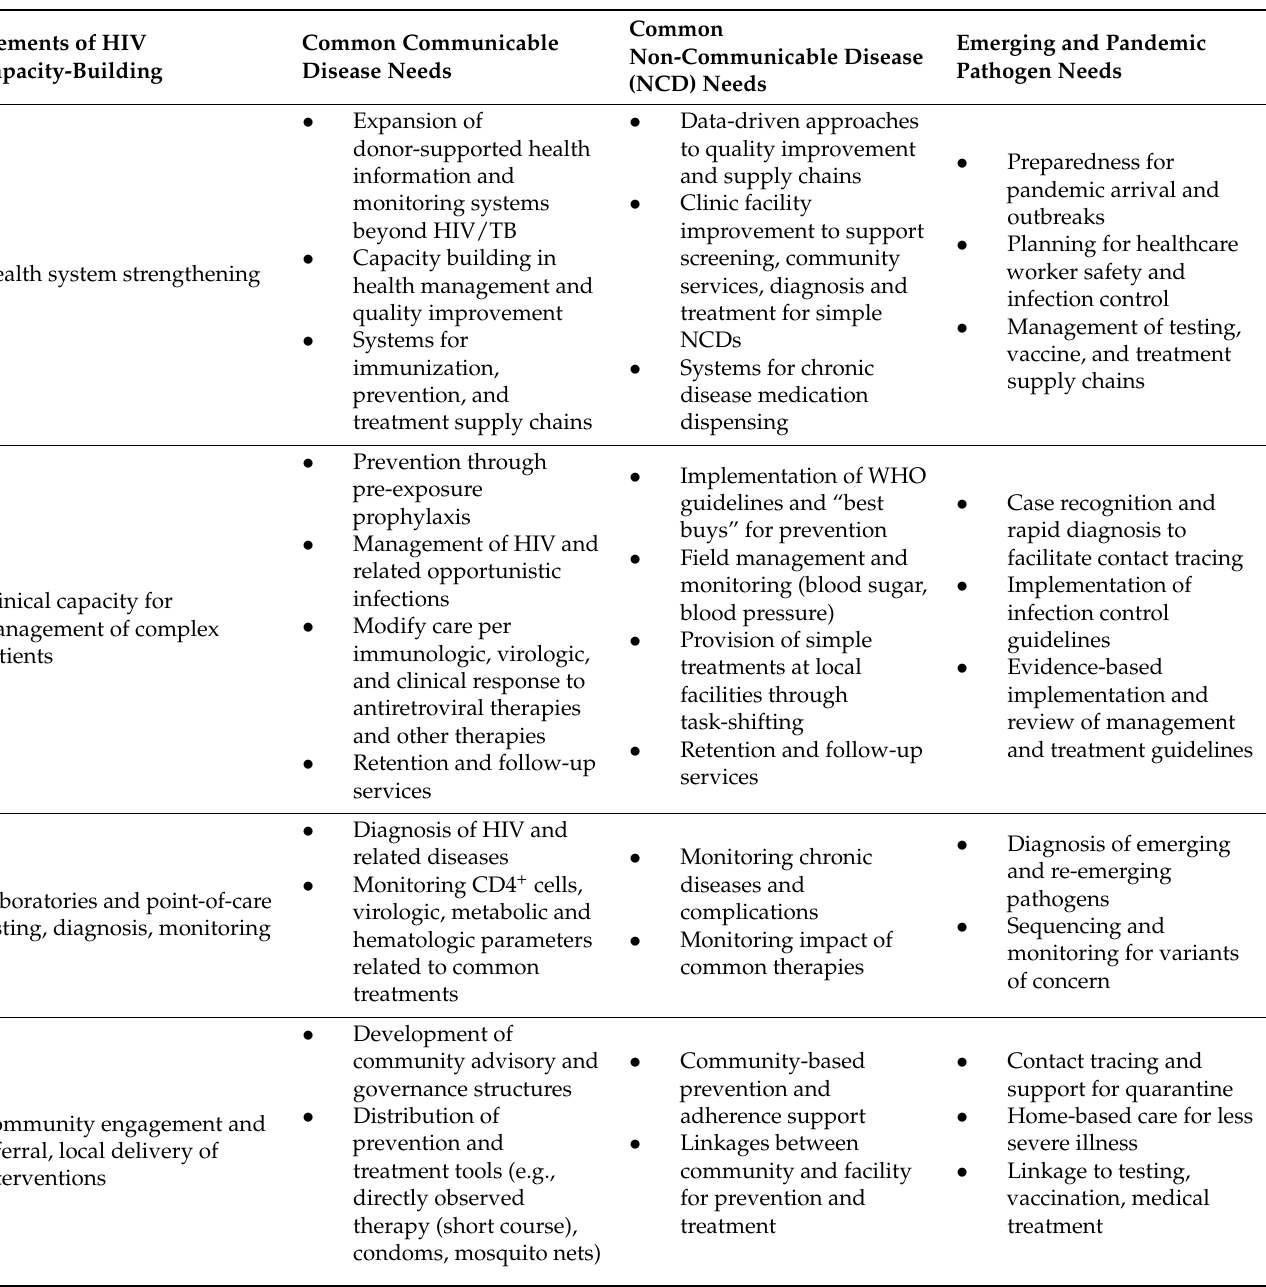
Table 1. Examples of shared needs across disease types, and ways in which HIV capacity building could be applied across these